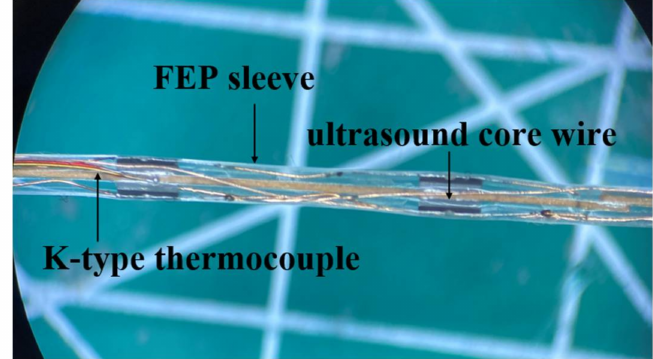
Figure 2. Ultrasound-based prototype catheter.